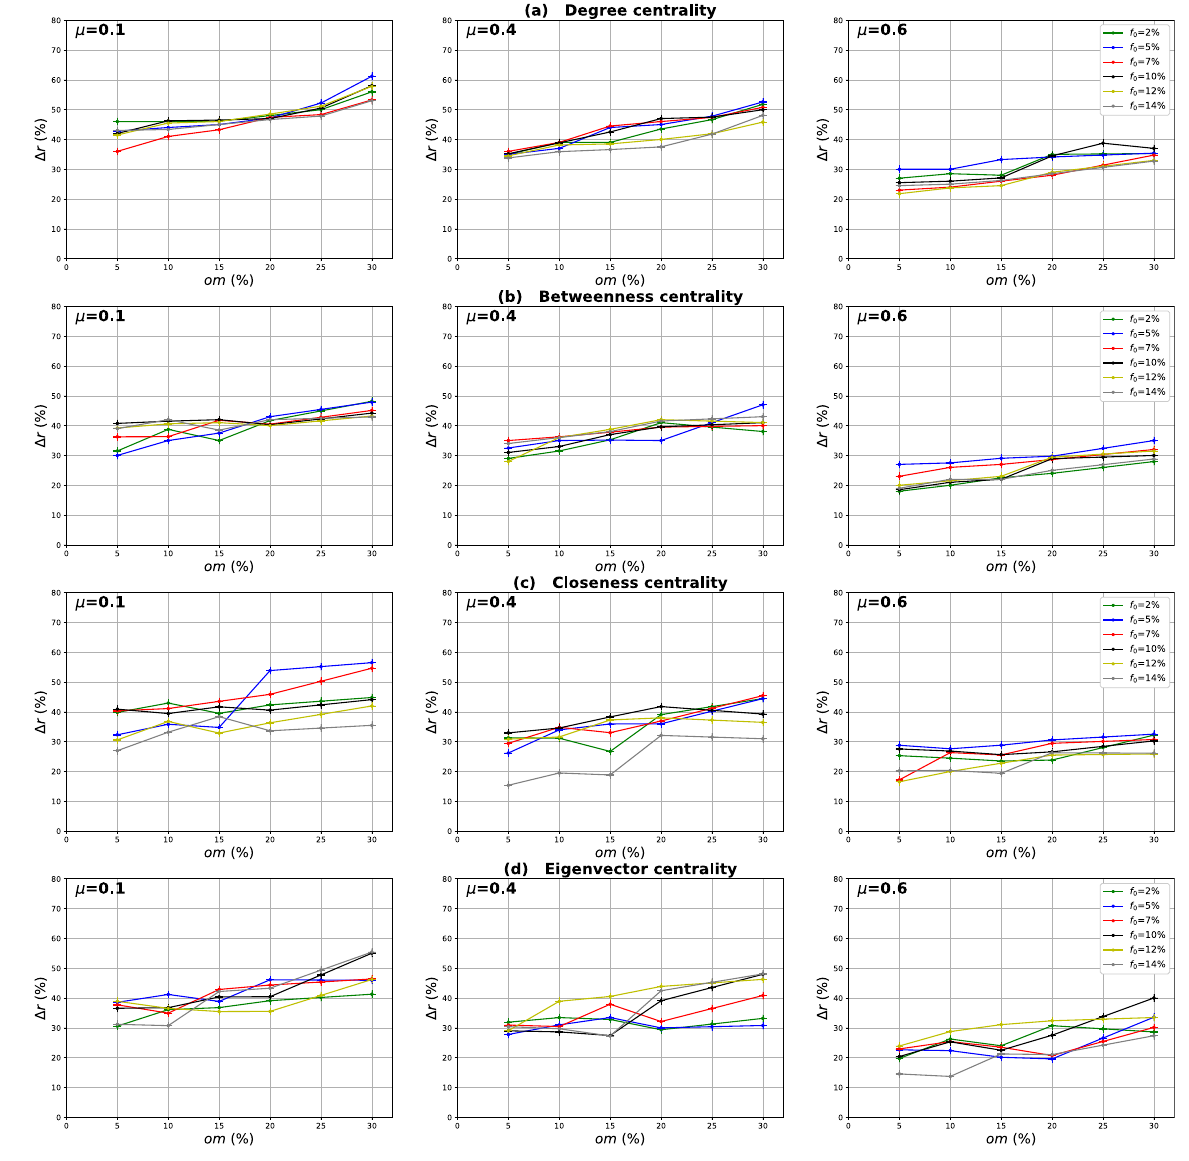
Figure 15. Influence of the community membership degree. The relative difference of the outbreak size Δ r between the standard measure and the Modulus measure versus the membership degree om . The number of overlapping nodesvalue on is equal to 10% of the total number of